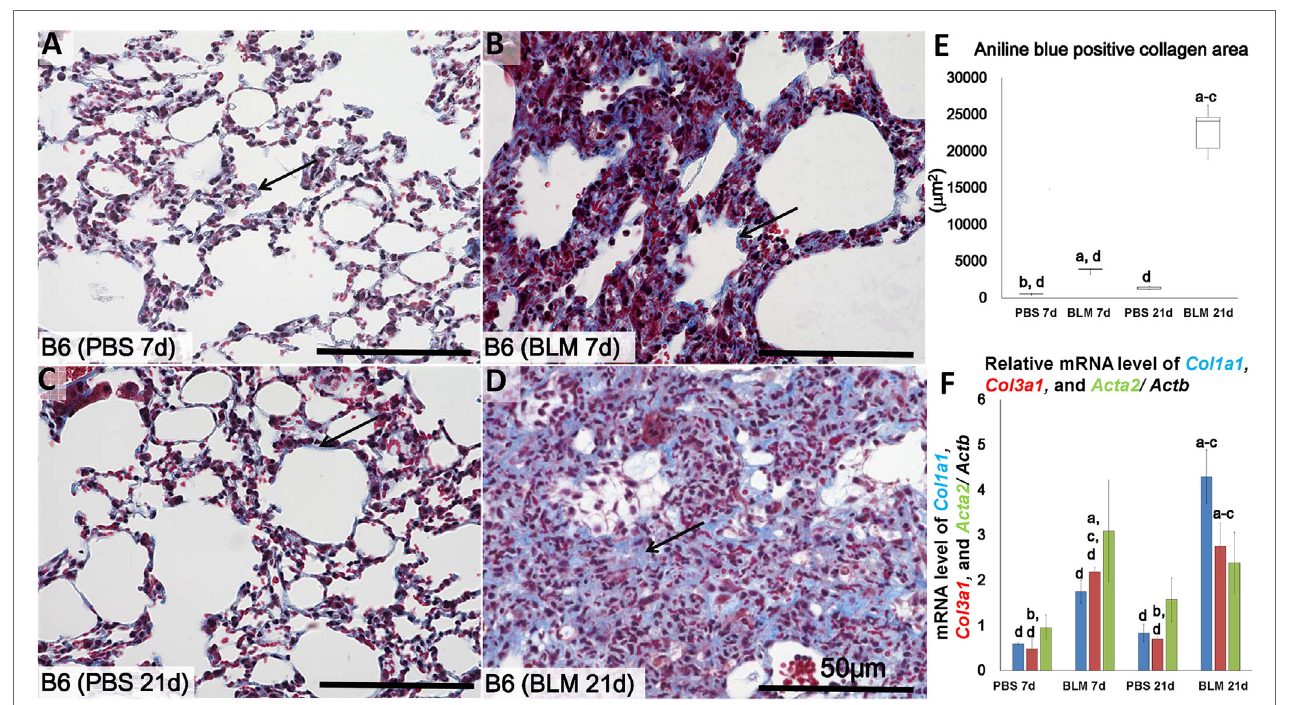
FigUre 1 | Identification of lung fibrosis in bleomycin (BLM) and phosphate-buffered saline (PBS) groups. Representative histopathological images of lung tissues stained with Masson’s trichrome at early stages (7 days after i.n. instillation of 50 µL of either PBS or 5 mg/kg BLM) (a,B) , respectively, and late stages (21 days after i.n. instillation of PBS or BLM) (c,D) , respectively. Arrows indicate collagen fibers. (e) Comparison of aniline blue + collagen areas in lung tissues of different groups. (F) Quantitative expression of mRNA for collagen 1a1 (col1a1), collagen 3a1 (col3a1), and alpha-actin-2 (acta2)/ Actb . The letters a, b, c, and d: significant differences between PBS group at 7 days (a), BLM group at 7 days (b), PBS group at 21 days (c), and BLM group at 21 days (d), analyzed by the Kruskal–Wallis test, followed by the Scheffé’s method ( P < 0.05); n = 5 in each experimental group. Values are given as the mean ±